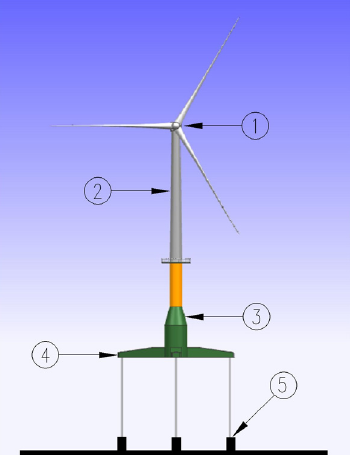
Figure 1. Configuration of an offshore wind turbine with a mono-column TLP